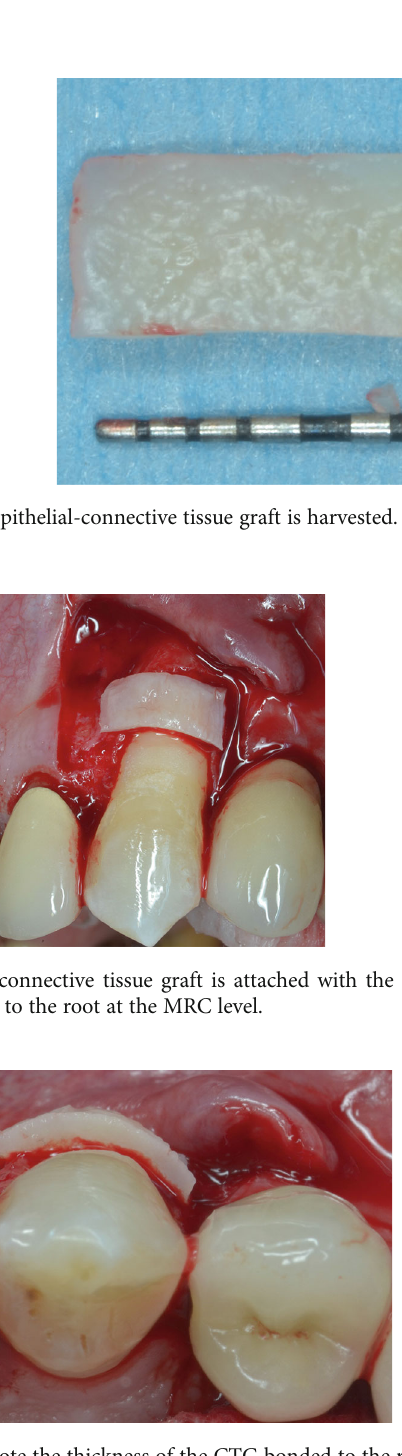
Figure 10: Note the thickness of the CTG bonded to the root.